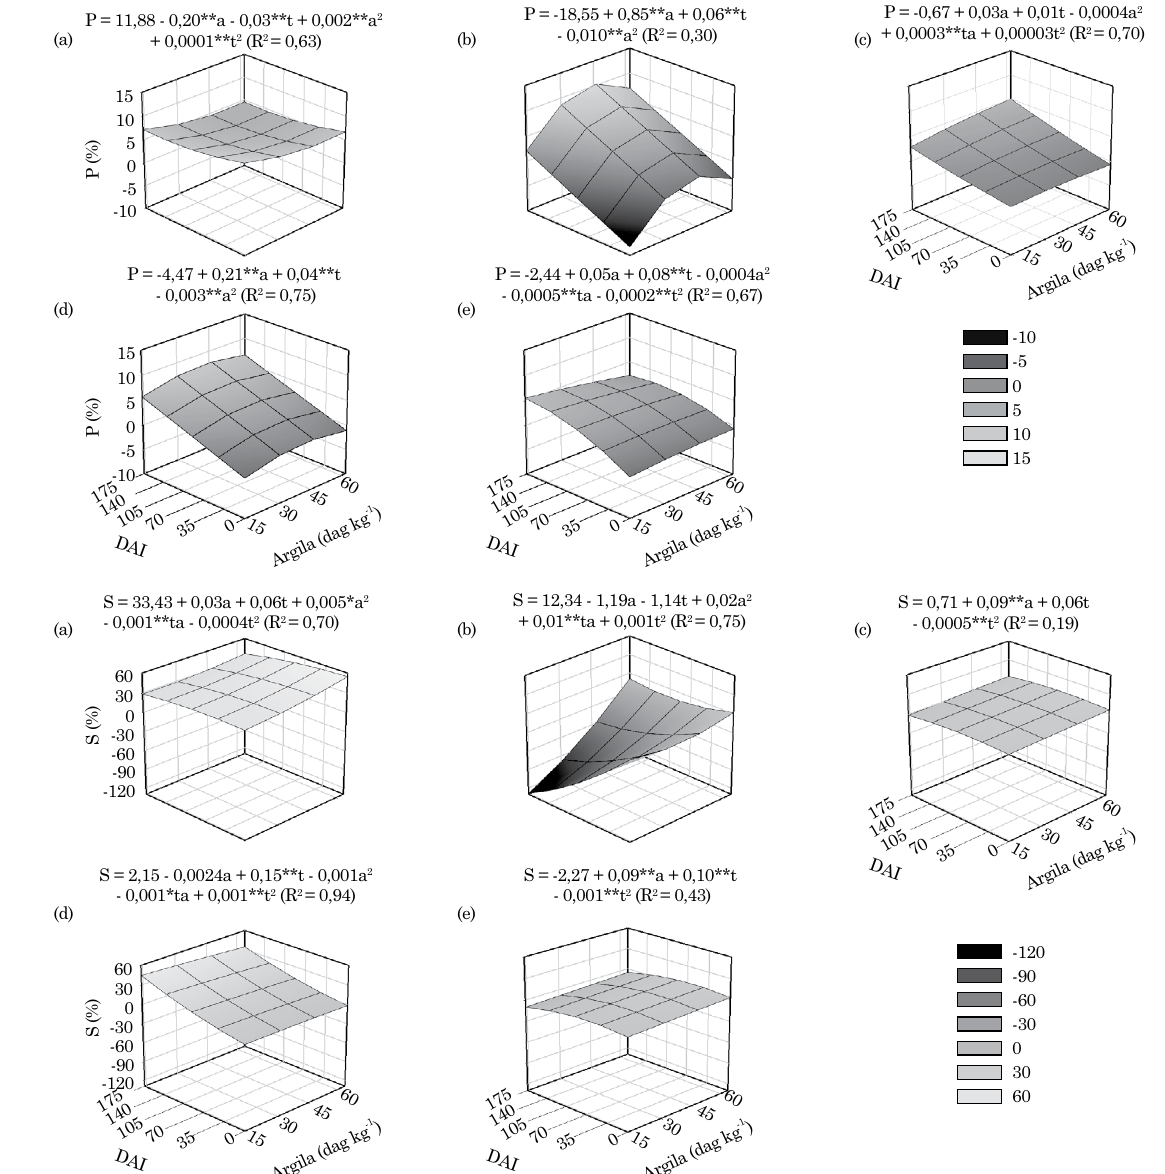
figura 6. taxas de recuperação do p e s, pelos extratores, nos solos com fontes inorgânicas dos nutrientes (a); e com resíduo de: milho (b), braquiária (c), feijão (d) e estilosantes (e). * e **: significativos a 5 e 1 %, respectivamente, referentes a: a – teor de argila, t – tempo e ta – interação entre esses. DAI: dias após o início da